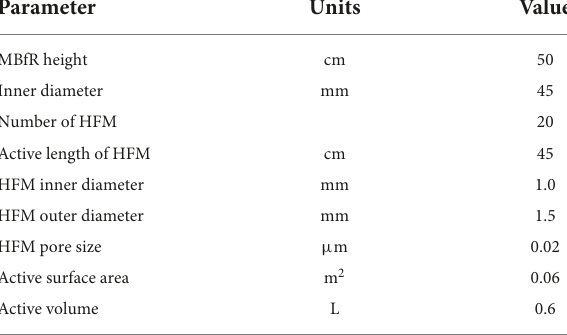
TABLE 1 Physical characteristics of the MBfR